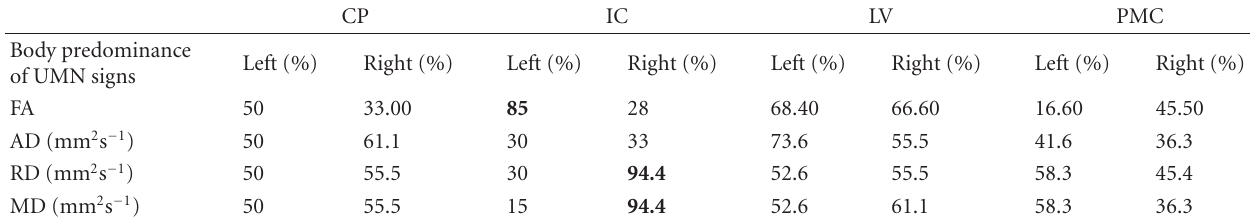
Table 1: Percent correspondence of abnormal CST DTI metrics with appropriate side of body showing more UMN